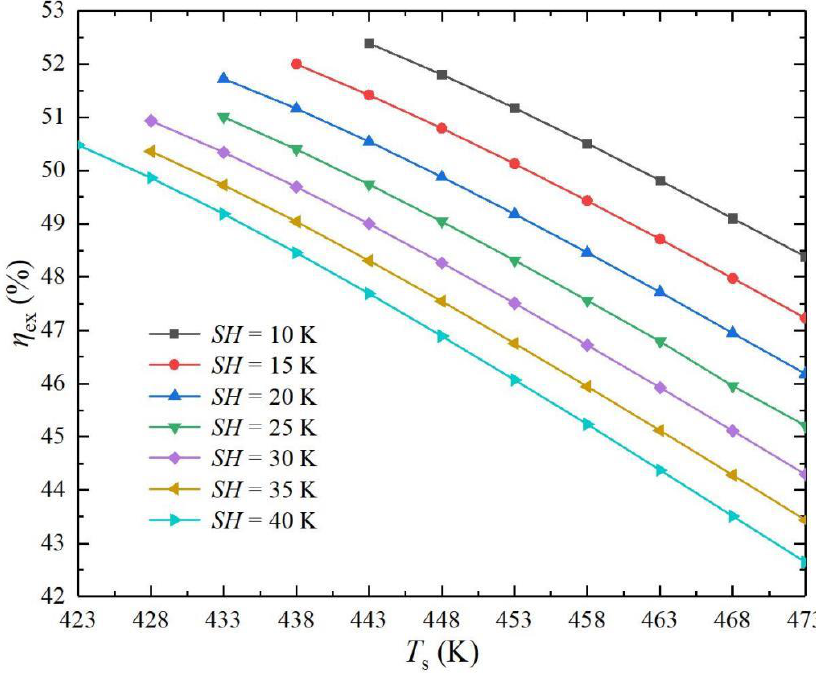
Figure 21. Exergy efficiency with heat-source temperature under different superheat degrees.